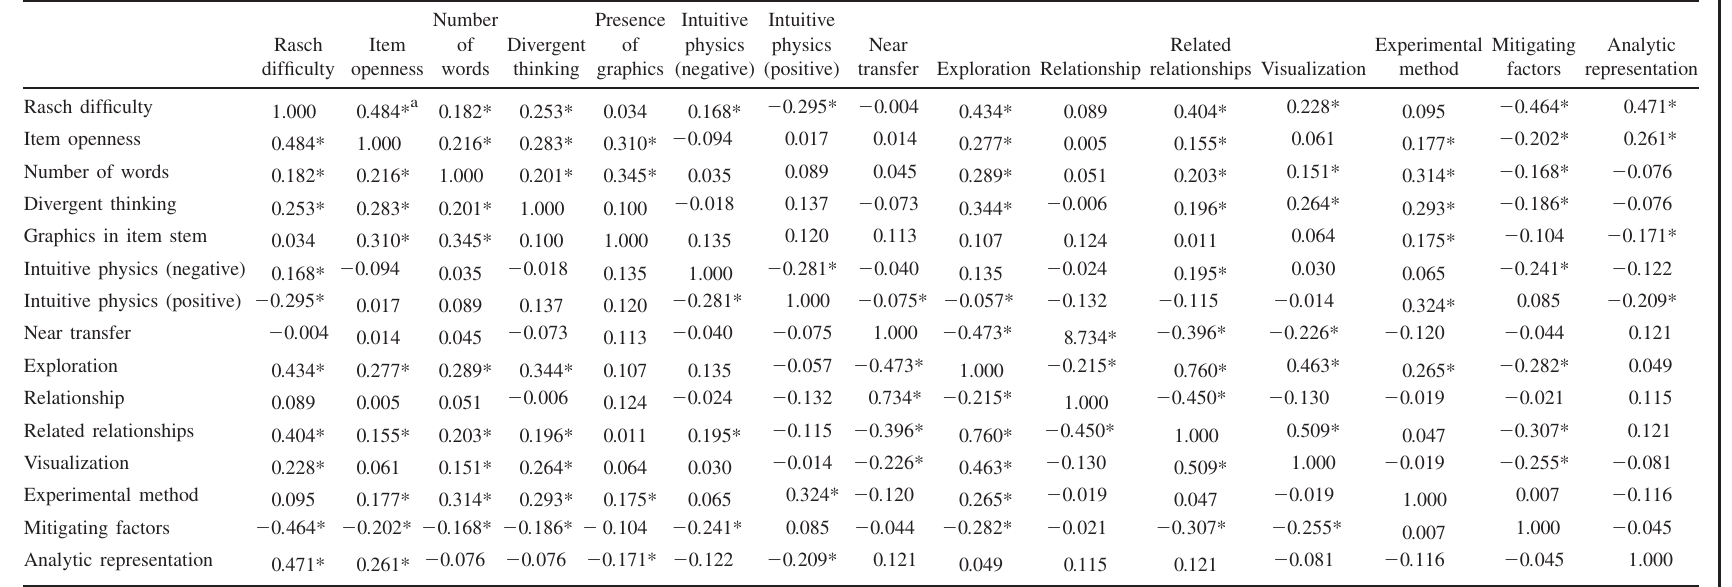
TABLE XIII. Zero-order correlation coefficients.